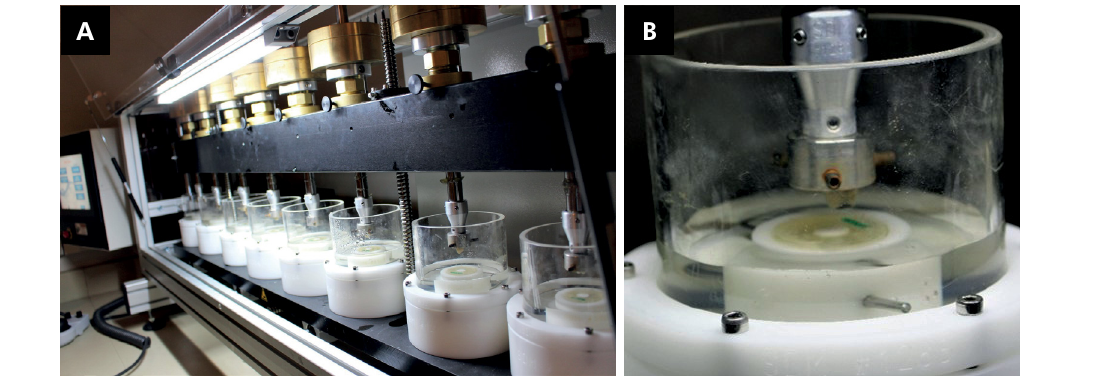
Figure 2. Wear simulator machine with specimens mounted for wear test (A); Close up view of specimens mounted in upper and lower holders